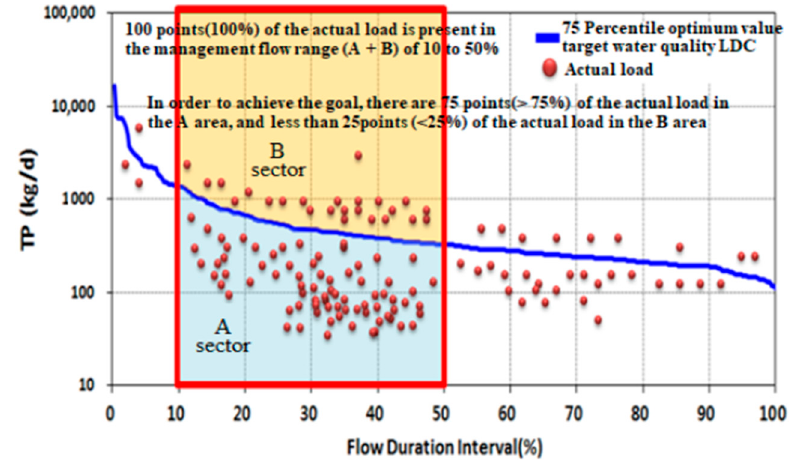
Figure 13. Example of management water quality target evaluation.